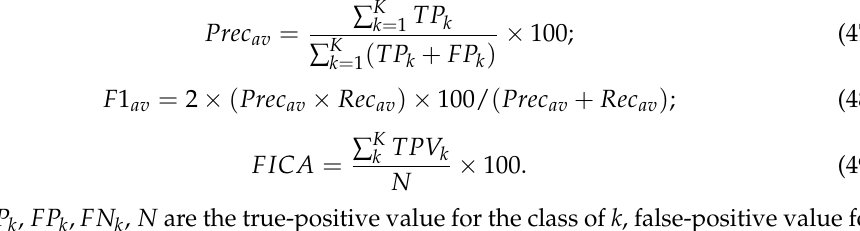
𝑃𝑟𝑒𝑐 𝐹1 𝑎𝑣 , 𝑎𝑣 , 𝑎𝑣 , and FICA averaged over 10 experiments Methods